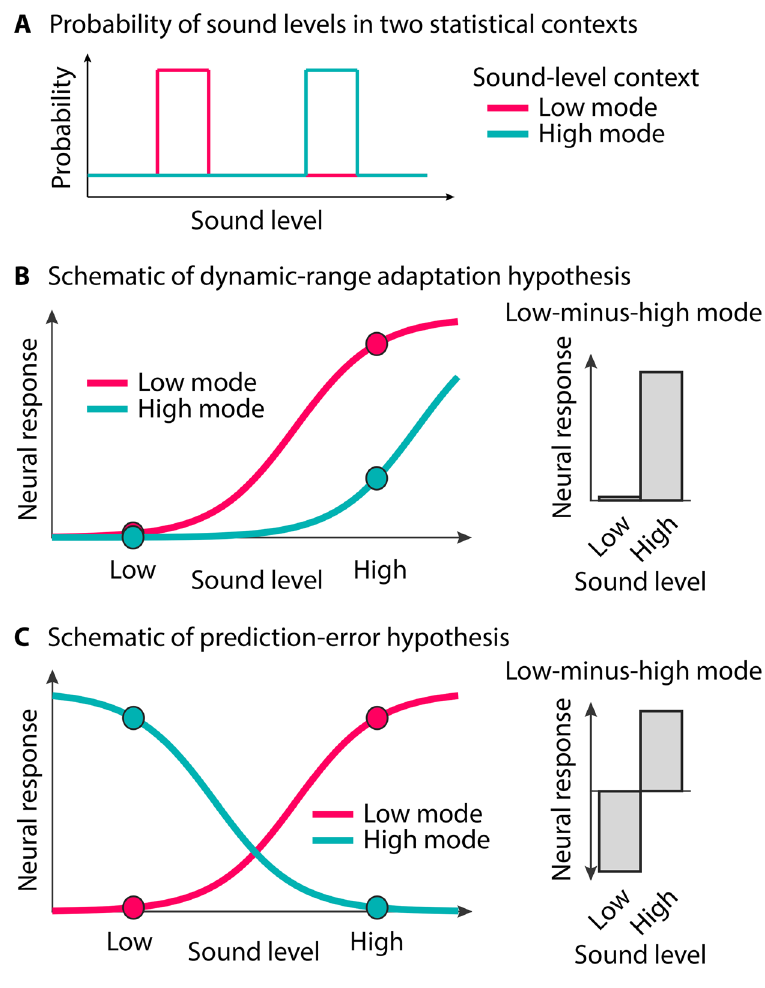
Figure 1. Schematic depiction of hypothesized effects of sound-level statistics on neural responses and behavior. ( A) Probability with which sound levels occur in two statistical contexts ( B ) Neural responses as a function of sound level for two sound-level contexts with different modal sound levels (low vs. high; panel A) predicted by the dynamic-range adaptation hypothesis. Dots mark two target-intensities (lower and higher), similar to the neural and behavioral analysis of empirical data (Experiment I & II). Gray bars indicate the difference between the low-mode and the high-mode contexts, separately for each target intensity 10,11,21 . ( C ) Similar as in panel B for the prediction-error